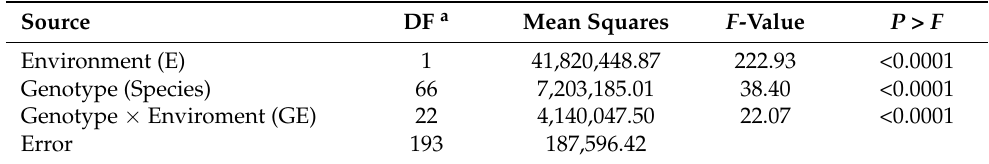
Table 3. Combined analysis of variance among genotypes of the five grain legume species growing under two environments (ENV1 and ENV2) for seed yield (kg ha − 1 ). Source DF a Mean Squares F